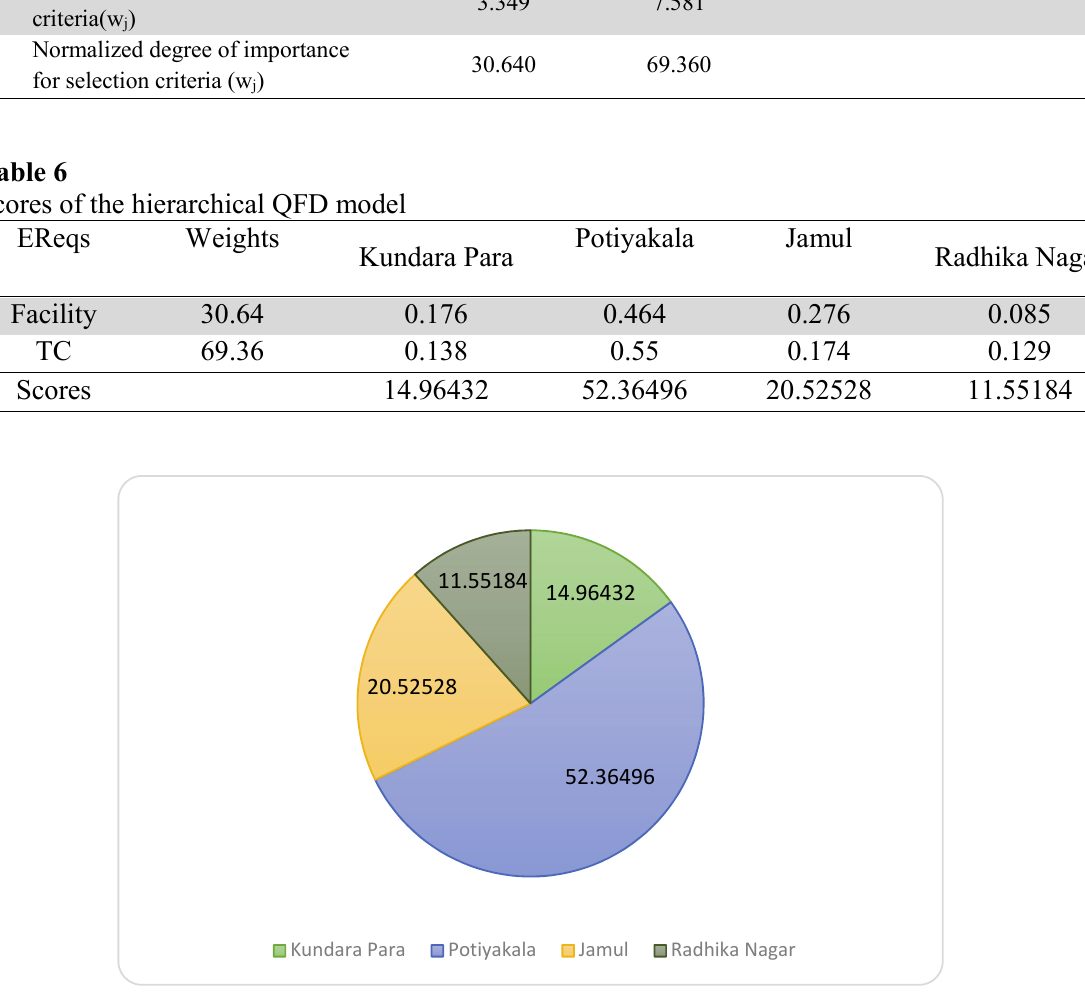
Fig. 2. Scores of the hierarchical QFD